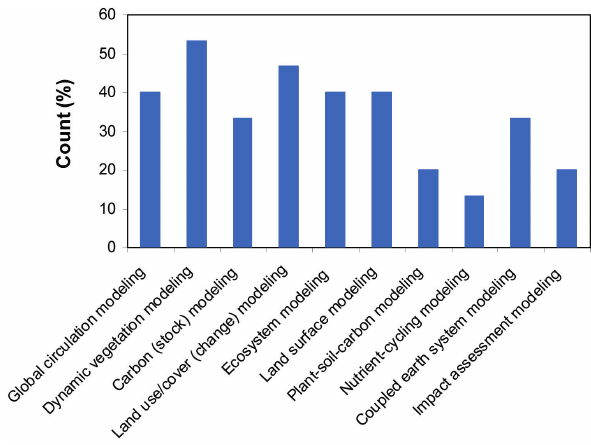
Fig. 1. Earth system or climate modeling focus of respondents to the associated users’ survey (each respondent having the possibility to have more than one